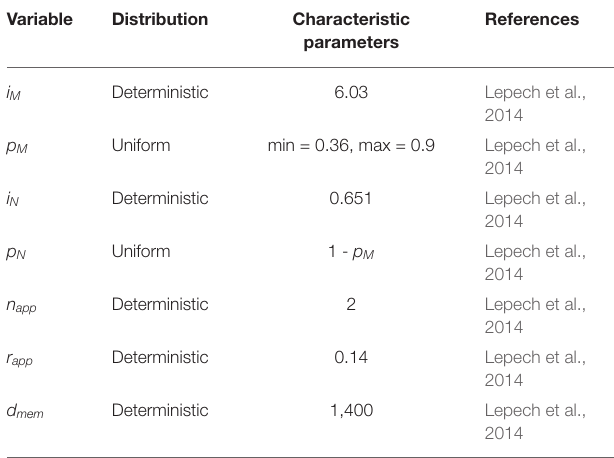
TABLE 5 | Membrane application environmental impact modeling variables, distributions, and parameters.